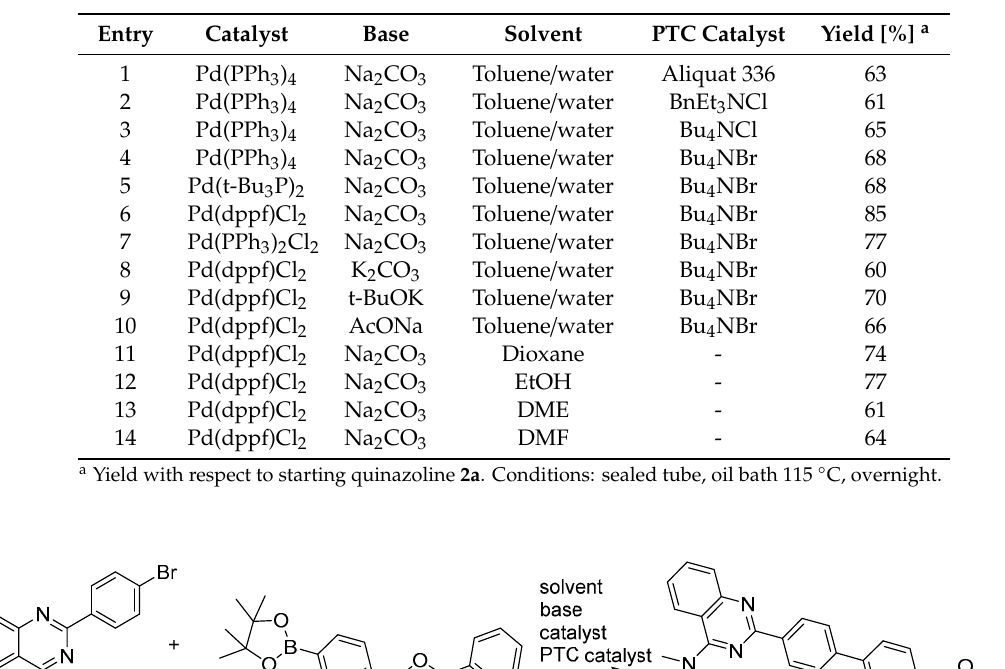
Table 1. Initial optimization for the cross-coupling reaction to obtain 8a .